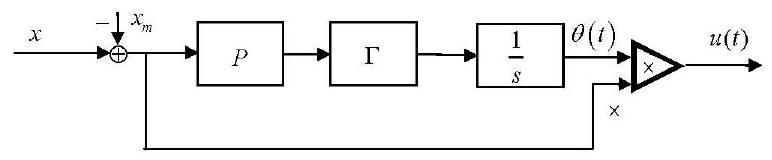
Figure 4. Adaptive control